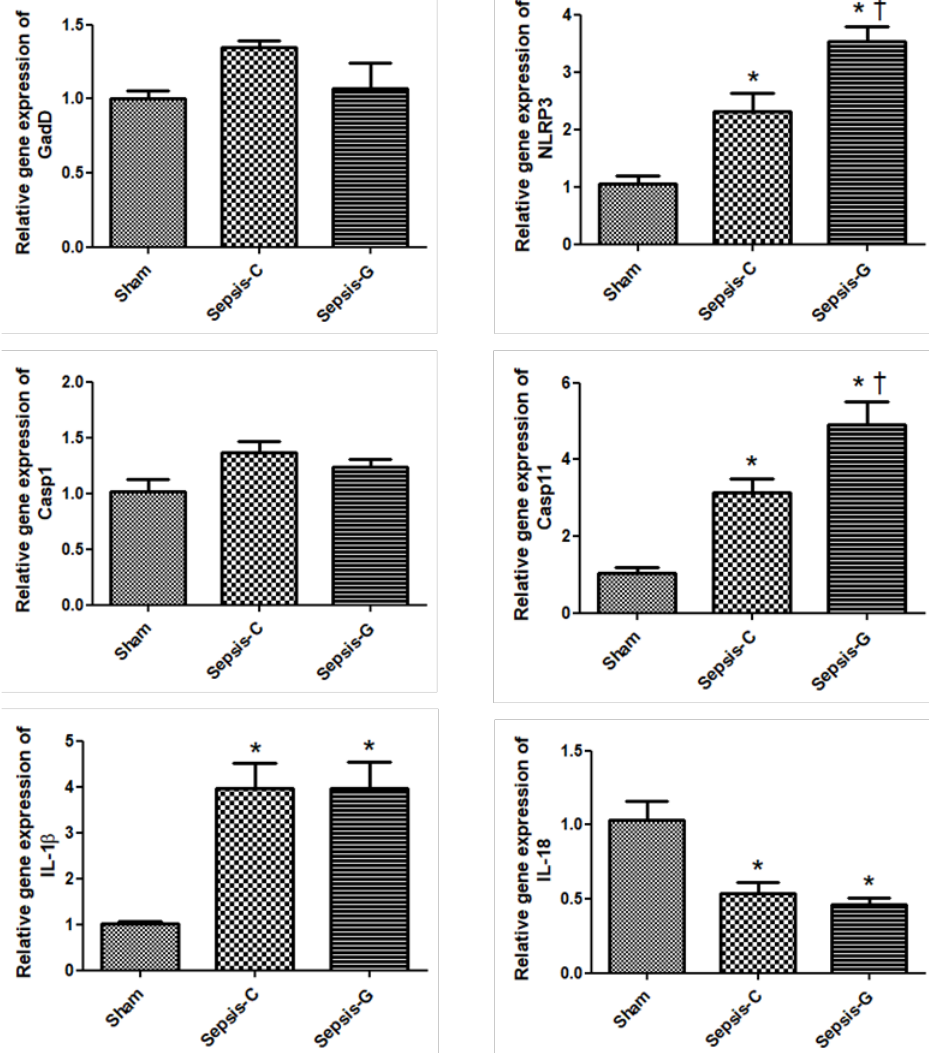
Figure 1. Expressions of genes related to pyroptosis in the liver 24 h after cecal ligation and puncture (CLP). Sham: control group with a sham operation; Sepsis-C: control group with CLP; Sepsis-G: glutamine (GLN) group with a CLP operation. Quantitation of mRNA changes was analyzed by a real-time Polymerase Chain Reaction (PCR) and was calculated by the comparative cycle threshold CT (2 − ∆∆ Ct ) method. mRNA expression levels in the sham control group were used as a calibrator. Data are shown as the mean ± standard error of the mean (SEM). n = 8 for each group. Differences among the sham, Sepsis-C, and Sepsis-G groups were analyzed by a one-way analysis of variance (ANOVA) with the Bonferroni post-hoc test. * Significantly differs from the sham group. + Significantly differs from the Sepsis-C group ( p < 0.05).